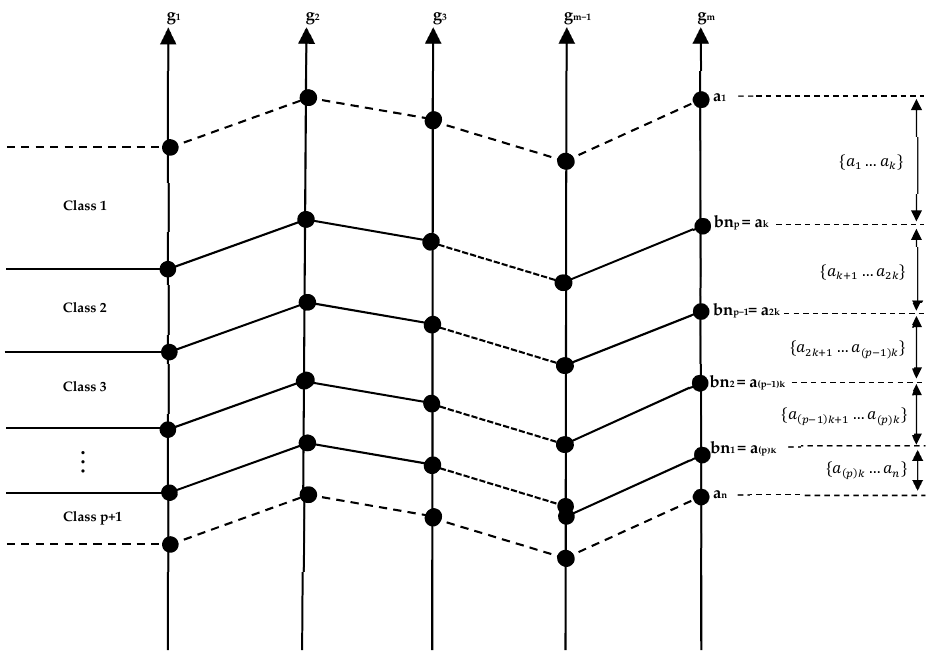
Figure 3. Procedure bn of the ELECTRE-MOr method. Cutting level: